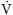
Association between the decline in CO2 production and development of emphysema.There was a significant correlation between the mean annual changes in peak V˙
co
2 (ΔpV˙
co
2) and those in the total LAA scores (ΔLAA) (p<0.0001, r = -0.488).